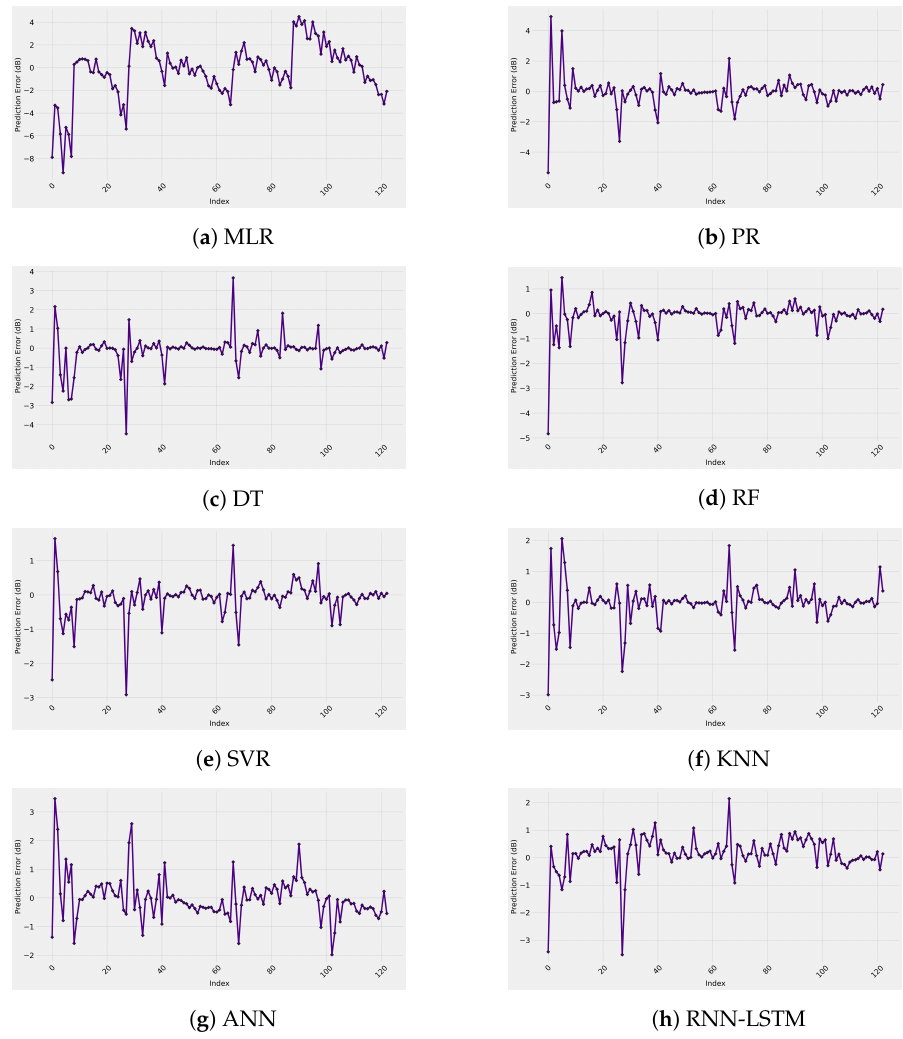
Figure 7. Prediction error of each ML-based